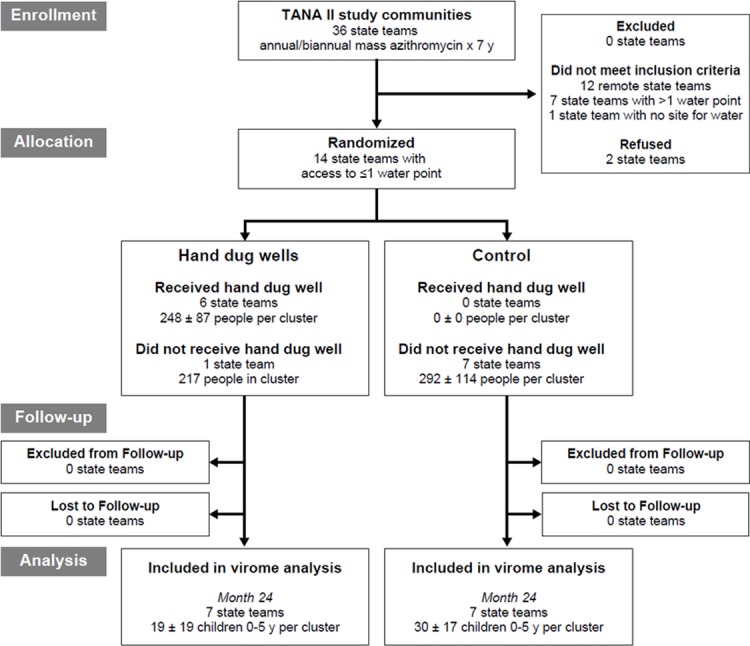
Flow diagram for collection of fecal samples.